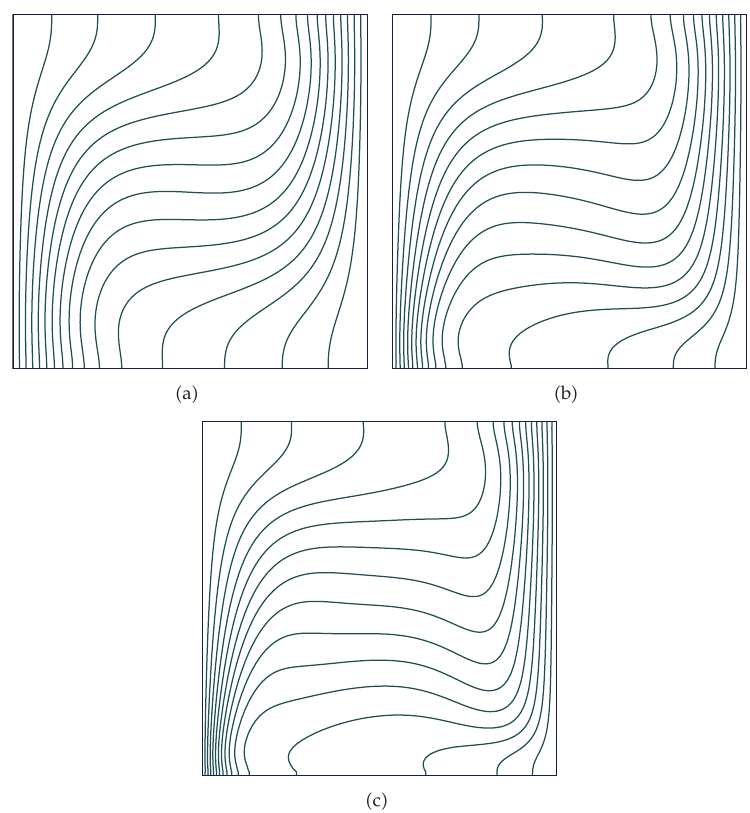
Figure 3: Isotherms for the thermomagnetic flow in a square cavity for Δ T (cid:8) 30K, Ra (cid:8) 10 4 : (cid:3) a (cid:4) m (cid:8) 0 . 0, (cid:3) b (cid:4) m (cid:8) 0 . 05, and (cid:3) c (cid:4) m (cid:8) 0 .